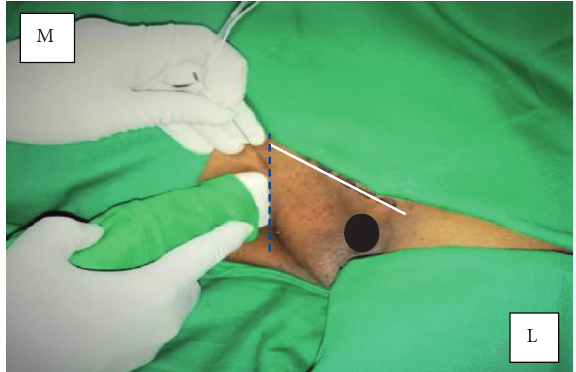
Figure 1: ICBN blockade using the linear probe using the in-plane approach. Black oval indicates the humeral head; white (solid line) indicates the anterior axillary fold, and blue (dotted) line indicates the 4th intercostal space. M: medial; L: